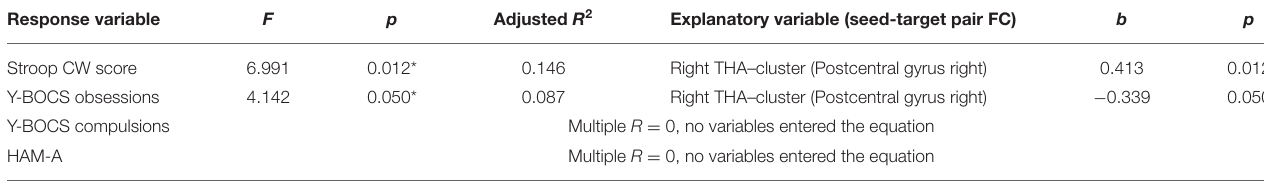
TABLE 5 | Results of the stepwise multiple regression